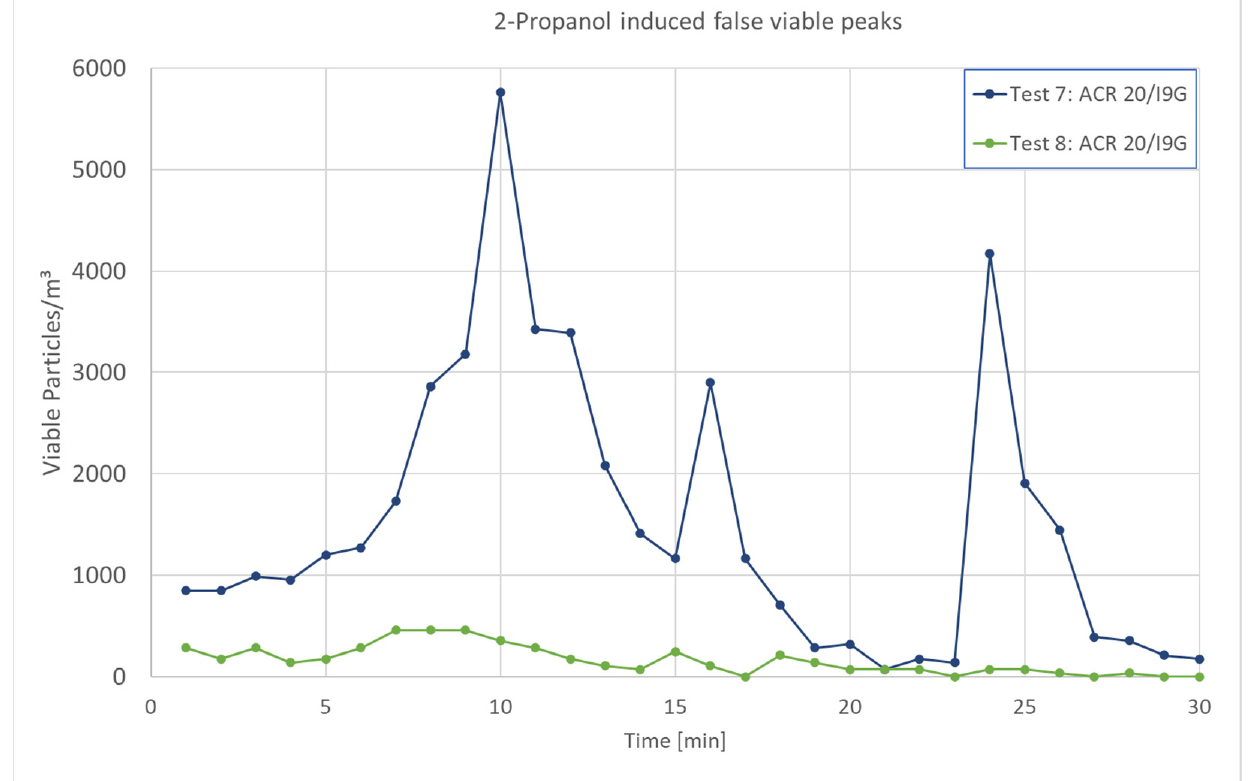
Figure 7. Effect of spray bottle use for hand disinfection.